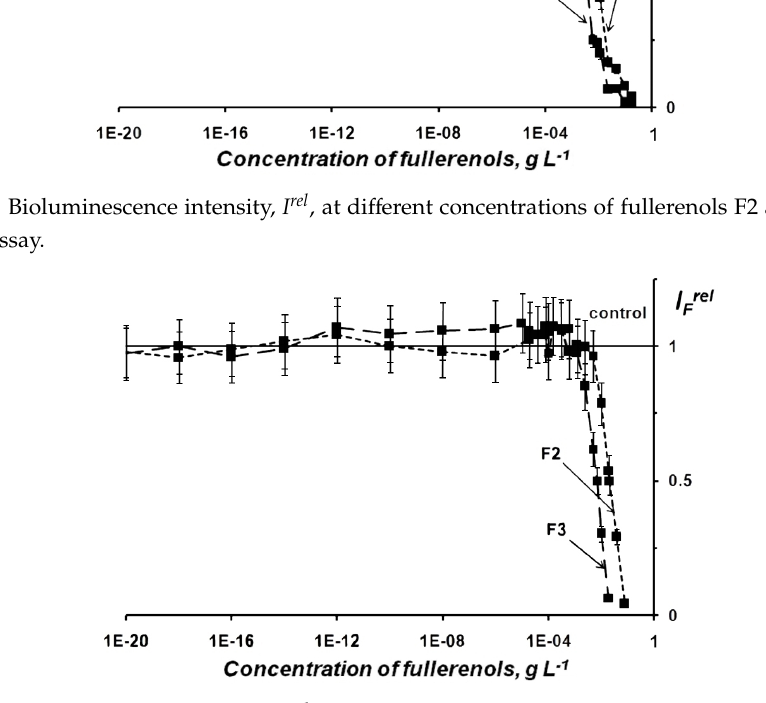
Figure 2. Bioluminescence intensity, I rel , at di ff erent concentrations of fullerenols F2 and F3 for the enzymatic assay. Table 2. Values of e ff ective concentrations EC 50 of fullerenols F1–F5 and concentration range (CR) of F1–F5 for decreasing bioluminescent intensity less than 10% for both enzymatic and cellular